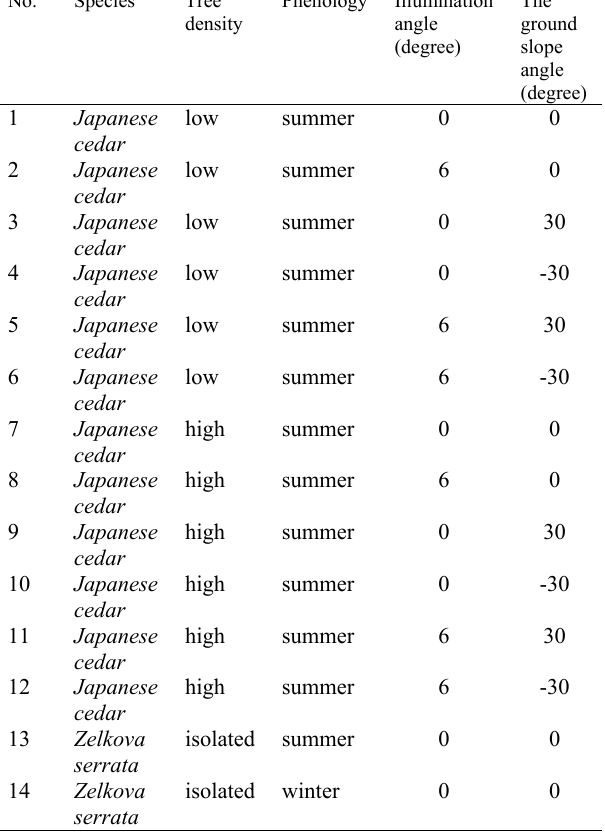
Figure 2. The simulated echo signals of scenario no.1 (a)